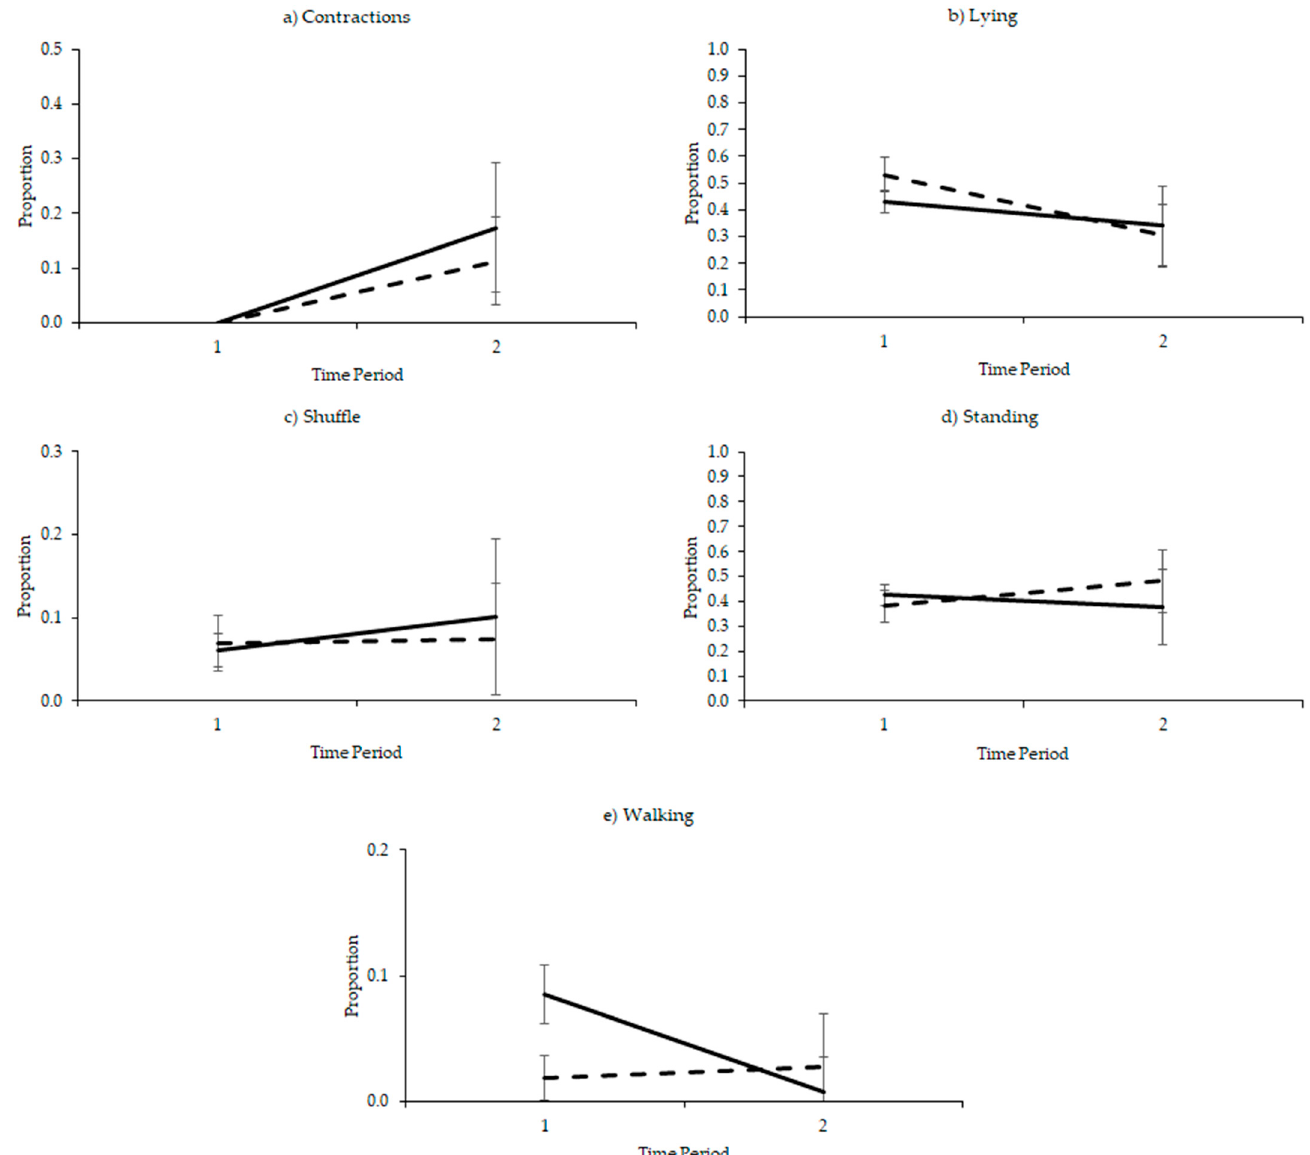
Figure 2. Predicted mean (±SEM) proportion of time that were ( a ) contractions, ( b ) lying, ( c ) shuffling, ( d ) standing and ( e ) walking behavior for assisted (dashed line) or non-assisted (solid line) lambing in time Periods 1 or 2, with Period 2 ending with the lambing event.